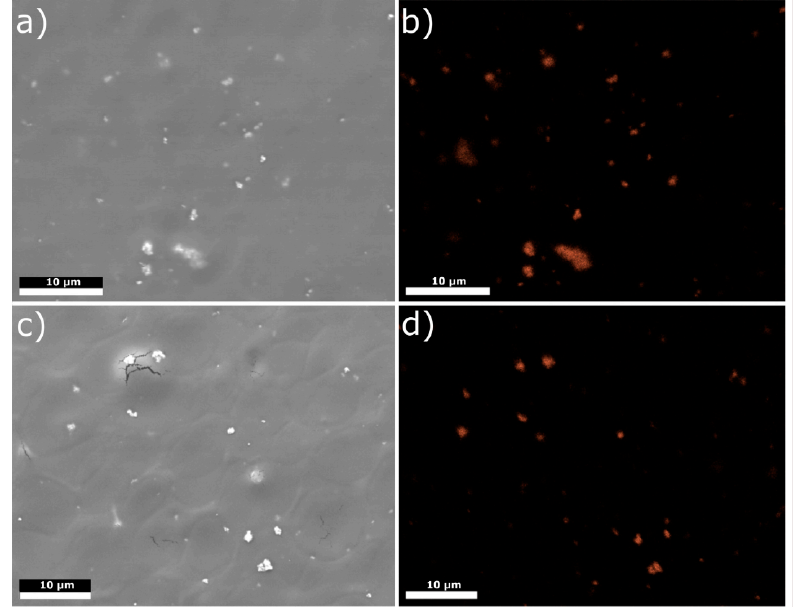
Figure 4. SEM images ( a , c ) and Ag distribution maps ( b , d ) of a selected area of ( a , b ) A1 and ( c , d ) B1